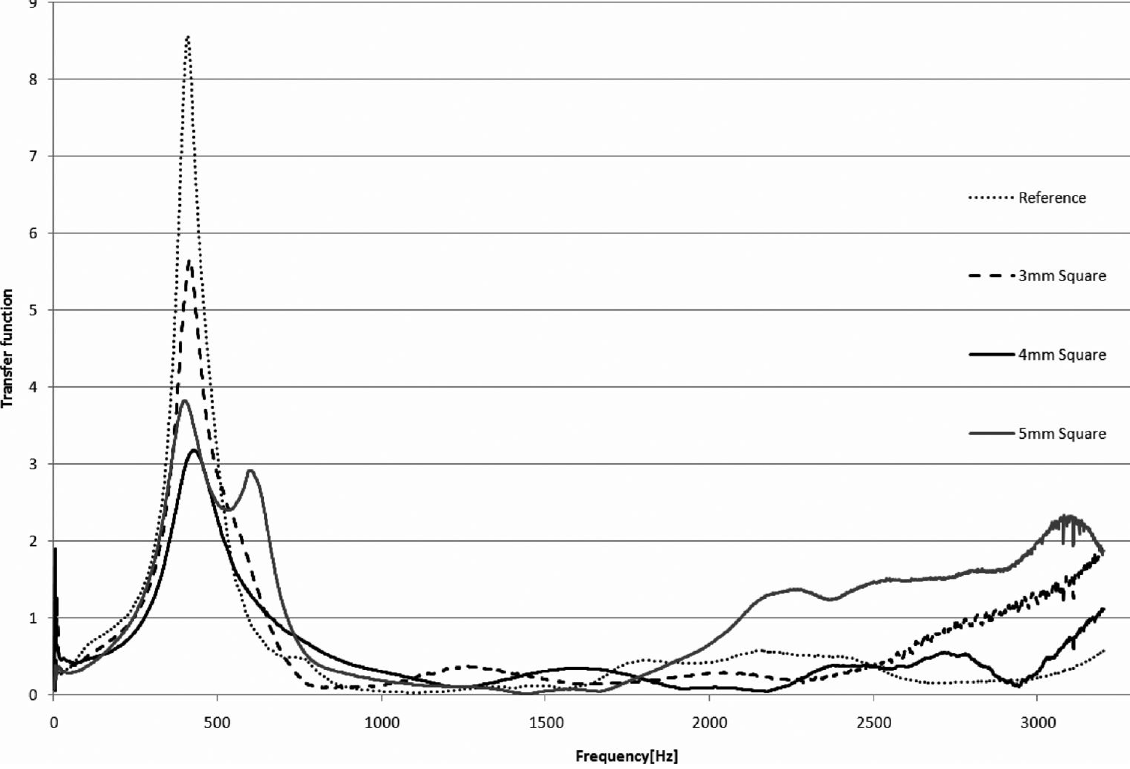
Fig. 64. EIDL Transfer function curves – Square Vs.